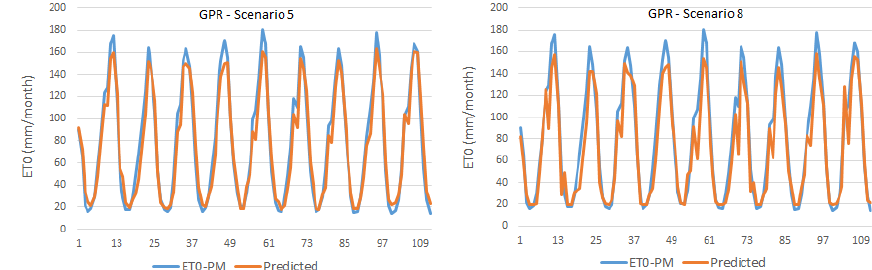
Figure 5. Time series graphics of GPR-estimated and FAO56PM-estimated ET 0 in scenarios 5 and